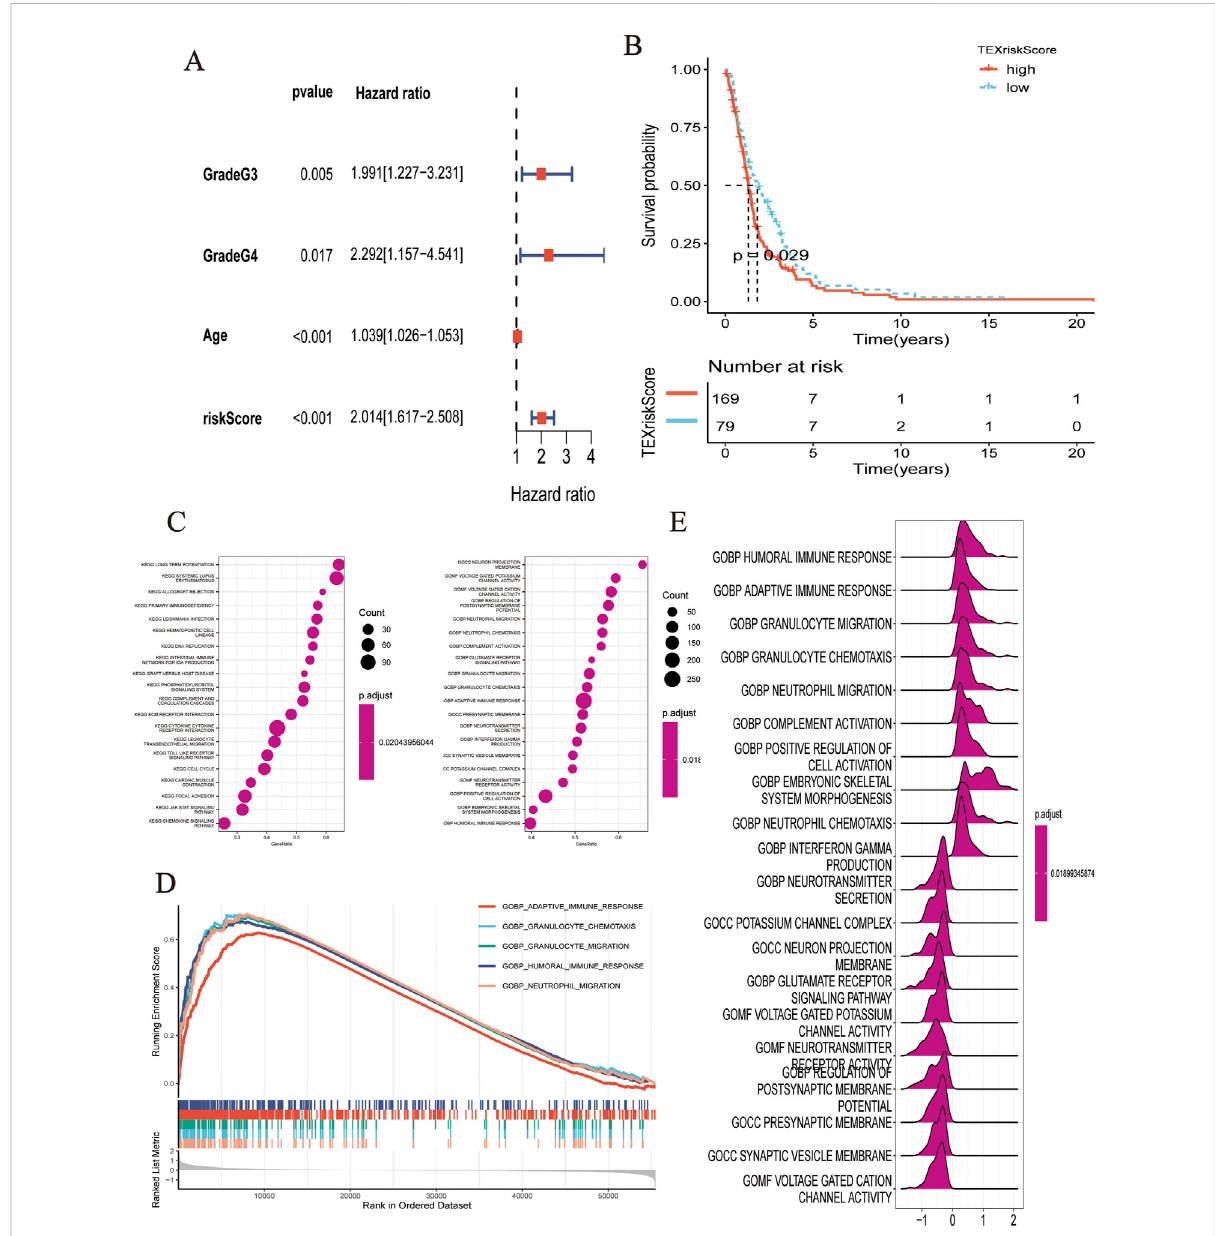
FIGURE 3 (A) Multivariate COX regression analysis demonstrated that RiskScore was an independent predictor. (B) K-M analysis showed the predictive performance of the model in external cohort. (C – E) Biological function analysis based on GO